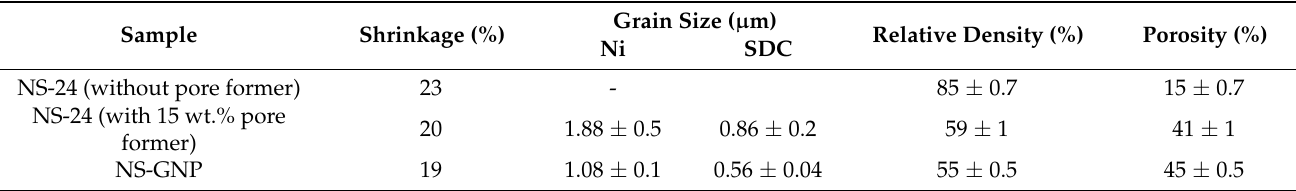
Table 1. Shrinkage, grain size, relative density, and porosity of Ni–SDC cermet anode prepared using different synthesis